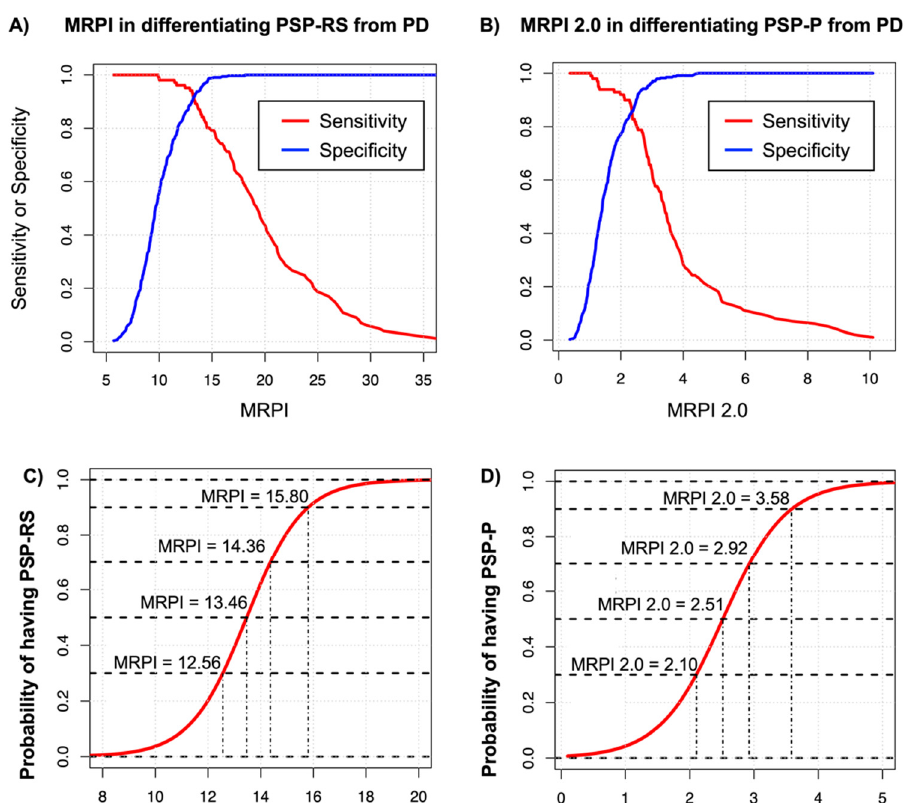
Figure 4. Abbreviations: PSP-RS—progressive supranuclear palsy-Richardson’s syndrome; PSP-P—PSP-Parkinsonism; PD—Parkinson’s disease; MRPI—Magnetic Resonance Parkinsonism Index. At the top are shown the automated MRPI ( A ) and automated MRPI 2.0 ( B ) cut-off values corresponding to different sensitivity and specificity thresholds. At the bottom, there is the probability of having PSP-RS rather than PD for each automated MRPI value ( C ) and the probability of having PSP-P rather than PD for each automated MRPI 2.0 value ( D ), obtained using logistic regression models balancing the number of PD and PSP patients. Data for the PSP-RS versus PD comparisons were obtained in the international cohort enrolled in the study by Nigro et al., 2020 [61]; data for the PSP-P versus PD comparisons were obtained in the international cohort enrolled in the study by Quattrone et